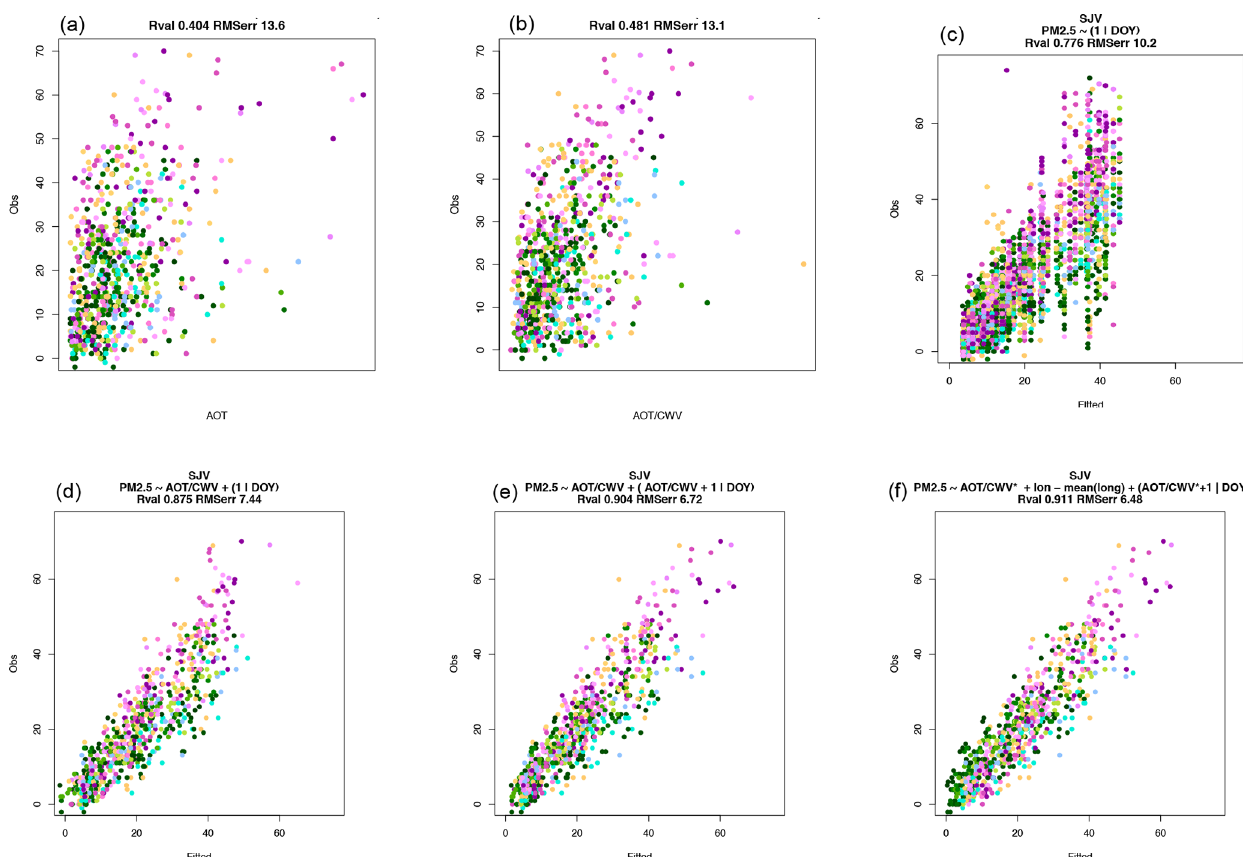
Figure 5. Progressive improvement of PM 2 . 5 simulation showing the roles of daily calibration and AOT / CWV descriptions of aerosol vertical dispersion. Station observations (µgm − 3 ) are shown on the y axis; estimators are shown on the horizontal axis. Note the progressive refinement of R and remaining root mean square error (RMSE); see text. (a) Use of AOT only, an early methodology. (b) Some improvement using AOT / CWV but no daily calibration. (c) More improvement with daily calibration (mixed effects using intercepts α i ) . (d) Clearly improved linearity when combing intercepts with AOT / CWV. (e) Estimating daily “random” intercepts and slopes improves RMSE and R . (f) A simple description of variation within the region (longitude) aids the estimation slightly (RMSE ∼ 6 . 48µgm − 3 , R ∼ 0 .